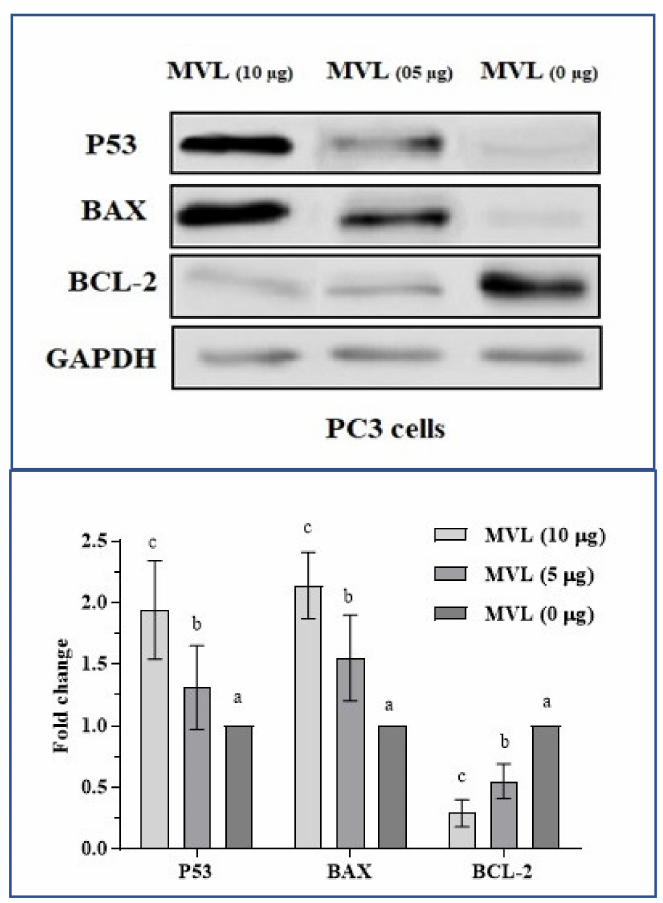
Figure 6. Western blot analysis of proteins associated with MVL induced apoptosis. Prostate cancer cells, PC3 were treated with MVL at a concentration of 0, 5, and 10 µ g/mL for 48 h. Data shows increased expression of pro-apoptotic P53 and BAX while decreased expression of anti-apoptotic BCL2. GAPDH was used as a loading control. Fold change in P-53, BAX, and BCL-2 expression after treating for 48 h with different concentrations of MVL. Means with different superscripts ( a–c ) indicate significant ( p < 0.001) difference in fold change between